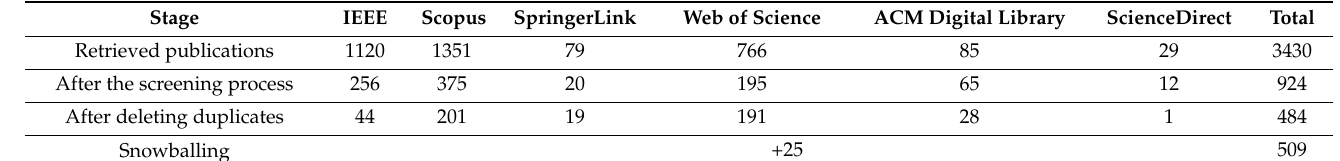
Table 2. Stages of the data collection process and numbers of publications